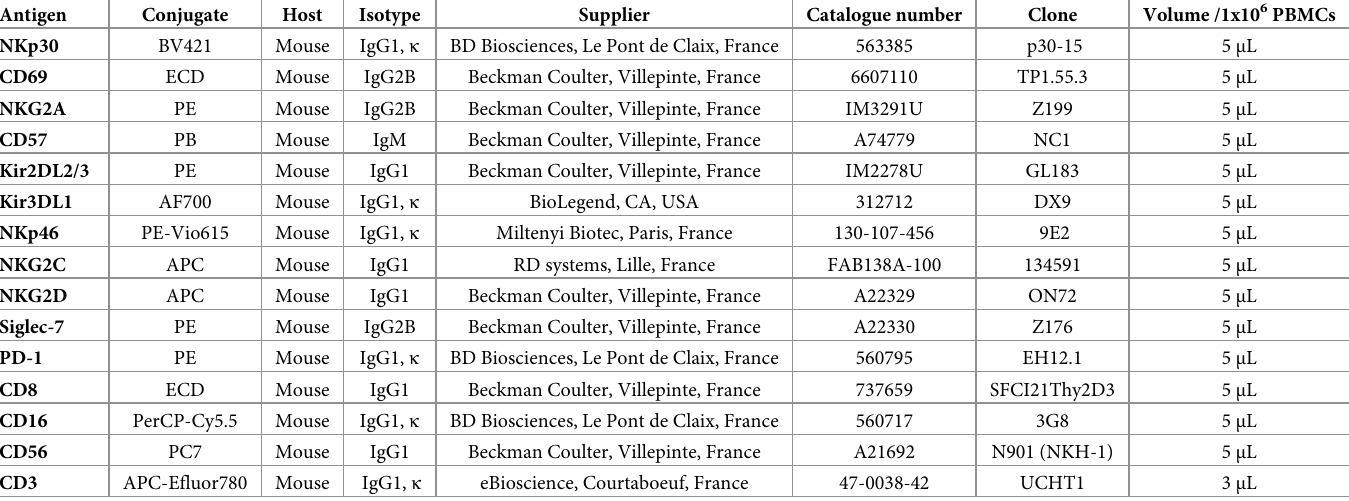
Table 2. Stained cells were washed with Dulbecco’s phosphate-buffered saline (PBS 1x; Thermo Fisher Scientific) and fixed with 300 μ L of BD CellFIX 1x (BD Biosciences). At least Table 2. Primary antibodies used for NK cell detailed phenotype.